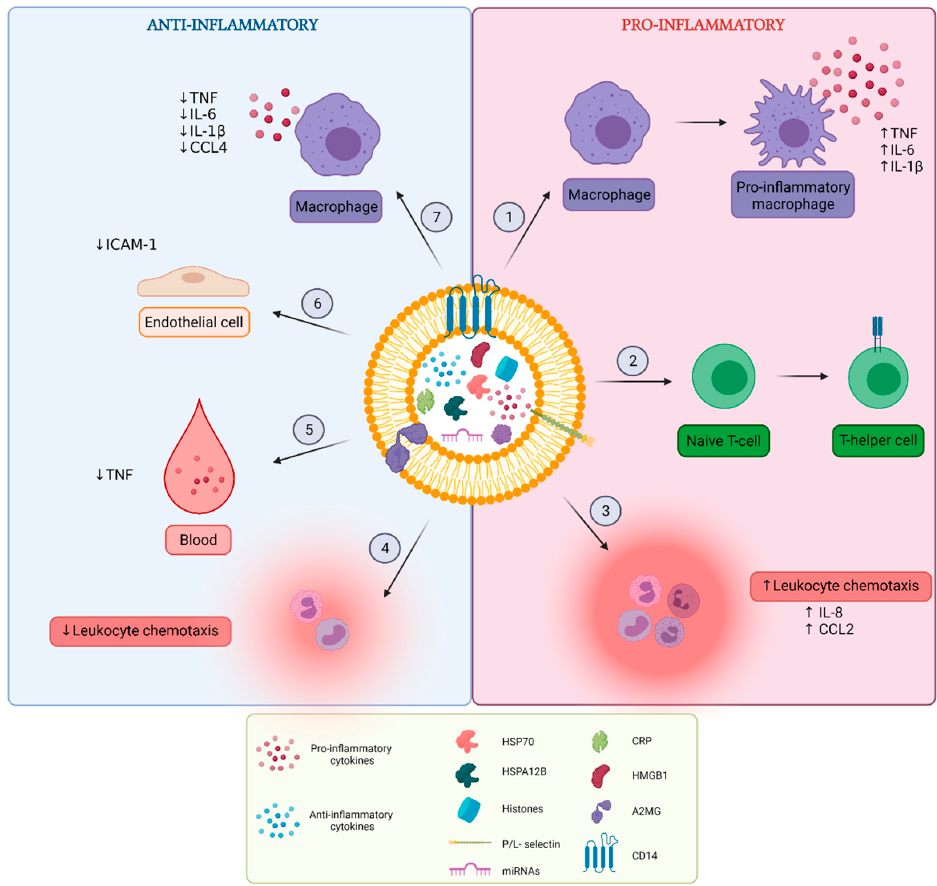
Figure 3. Overview of pro- and anti-inflammatory functions of extracellular vesicles (EVs). EVs released in vitro after cellular stimulation or EVs isolated from blood of sepsis mouse models and patients carry different inflammatory molecules including cytokines, chemokines, growth factors, histones, high-motility group box-1 (HMGB1), heat shock proteins (HSPs), C-reactive protein (CRP) and miRNAs. It is not always specified whether these molecules are present inside or at the surface of EVs. Pro-inflammatory effects of sepsis EVs include ( 1 ) induction of macrophage polarization to their pro-inflammatory phenotype and augmentation of pro-inflammatory cytokine secretion by macrophages, ( 2 ) induction of T-cell differentiation from naïve T-cell to T-helper cell phenotype, and ( 3 ) stimulation of leukocyte chemotaxis. Anti-inflammatory effects include ( 4 ) reduction of leukocyte chemotaxis, ( 5 ) reduction of pro-inflammatory cytokine levels in the blood, ( 6 ) reduction of adhesion molecule expression on endothelial cells and ( 7 ) reduction of pro-inflammatory cytokine secretion by macrophages. Figure created with